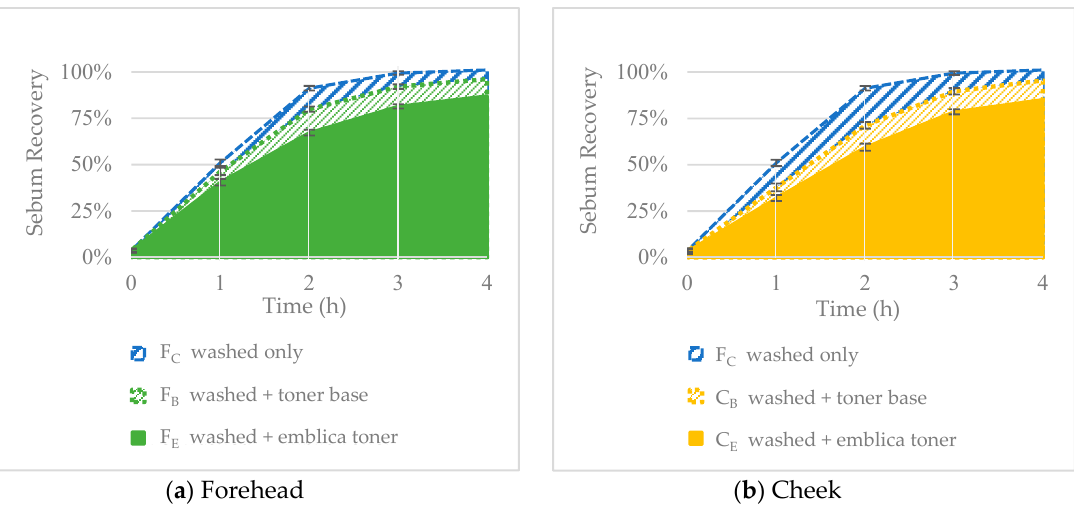
Figure 6. Area under the curve (AUC) of sebum recovery of the emblica toner and the toner base on ( a ) forehead and ( b ) cheek skins, at different periods of treatment compared with the control treatment (washed only), of 30 volunteers.